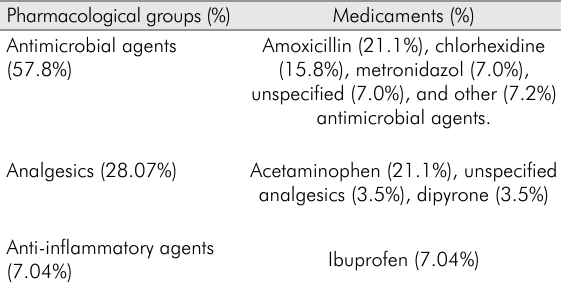
Table 1. Pharmacological groups and medicaments prescri- bed after the dental consult in the urgency